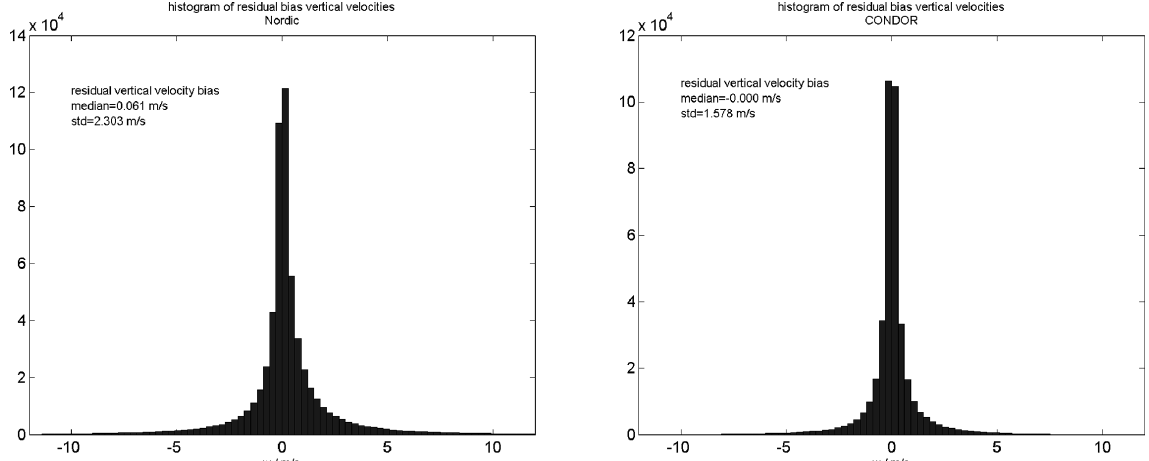
Figure 15. Histograms of the residual vertical velocity bias derived from the 3D-Var retrieval for three successive days and integrated over the full 3-D domain